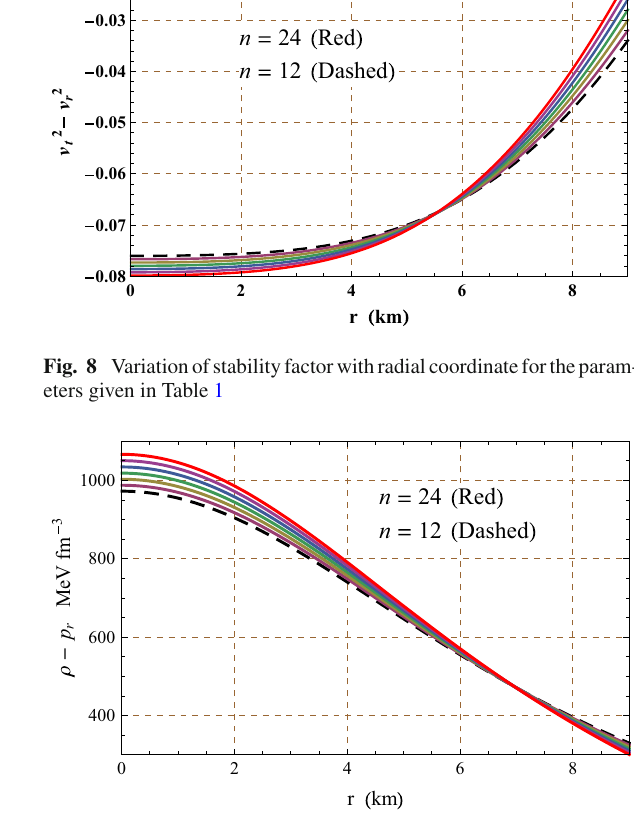
Fig. 9 Variation of ρ − p r with radial coordinate for the parameters given in Table